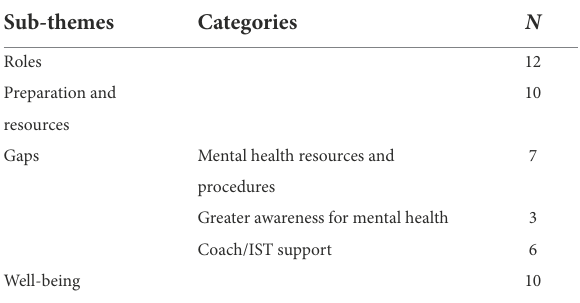
TABLE 4 The Impact of the pandemic on